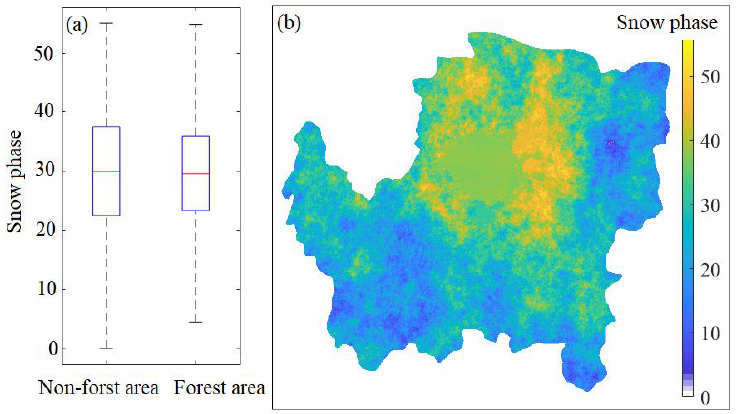
Figure 10. Snow phase after correction: ( a ) modified snow phase box-plot diagram, there is no abnormal value in both non-forest and forest areas; ( b ) snow phase diagram.